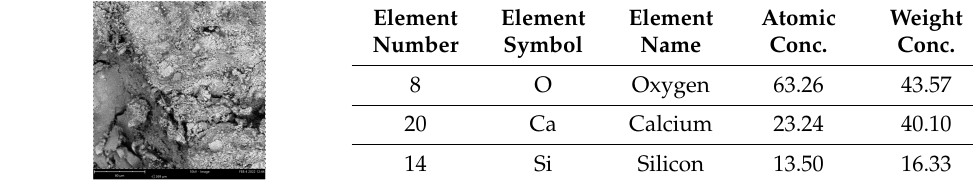
Table 15. SEM-EDS result for Y 4 concrete sample spot 1.